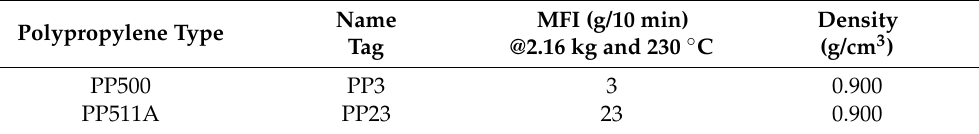
Table 1. Physical properties of the polypropylenes. Polypropylene